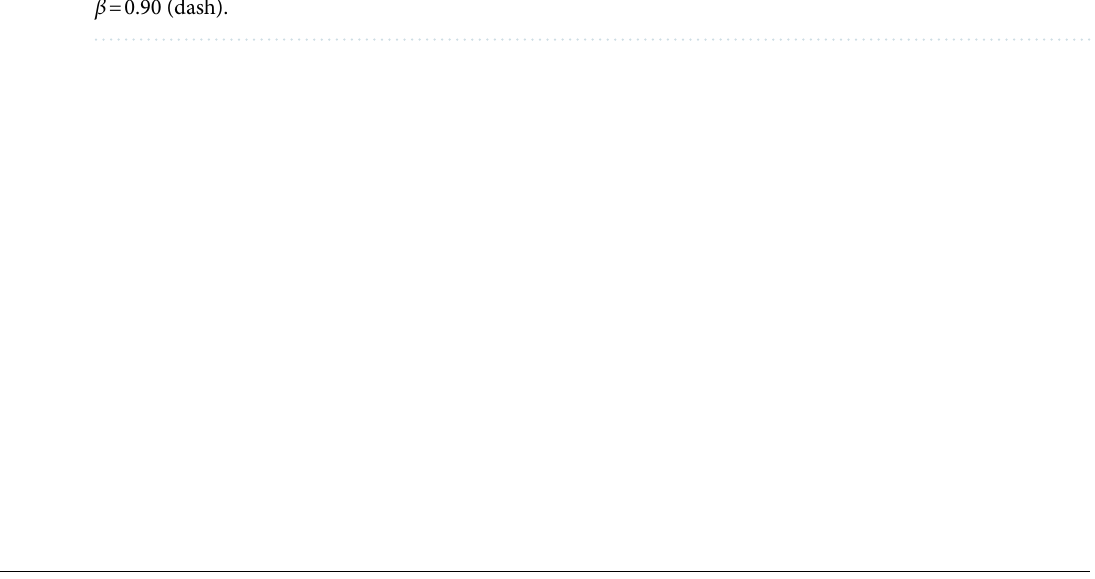
Figure 12. The case’s chaotic attractor dynamics, shown in 2D and 3D phase portraits when β = 1 (line) and β = 0.90